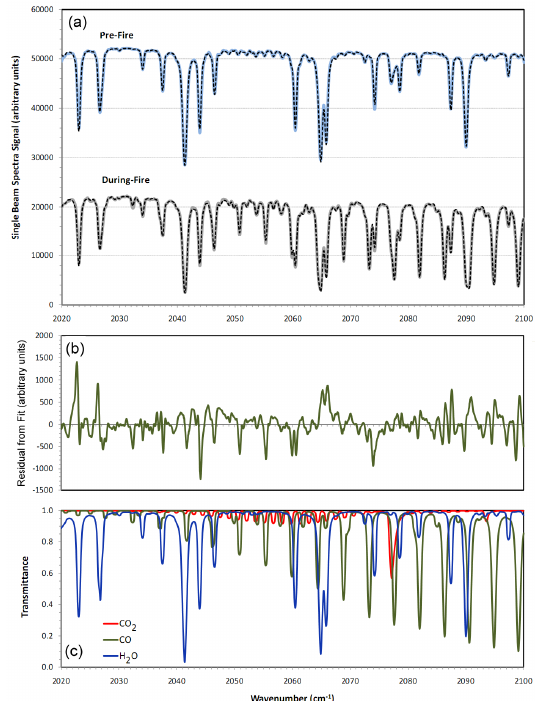
1403 1404 Fig. 5. Open path FTIR single beam spectra and best-fit forward modelled spectra for two example measurements recorded during Fire 1 (Table 1). Spectra were recorded by the deployed FTIR spectrometer operating in extended open path mode at 0.5cm − 1 wavenumber resolution, and the spectral window shown is the 2020–2100cm − 1 range used here for retrieval of CO 2 and CO abundances (Table 2). (a) Examples of single beam spectra mea- sured both prior to and subsequent to fire ignition, with the best-fit forward modelled spectra calculated using the retrieval procedure of Burton (1998) overlain in each case (dashed lines). The pre-fire and during-fire spectra correspond, respectively, to times 5 and 22min into the trace gas time series shown in Fig. 6. Pre- and during- fire spectra are shown offset for clarity. Note the greater number of strong absorption features in the during-fire spectra, caused by the increased within-plume trace gas abundances. (b) The resid- ual of the measured and best-fit forward modelled “during fire” spectra shown in (a) , indicating that no significant spectral features remain unfitted and confirming the strong agreement between the measured and forward-modelled spectra seen in (a) . Retrievals of CO 2 /CO column amounts from the pre-fire and during-fire spectra are equivalent to the ratio of path averaged mixing ratios (in ppmv) of 396/0.043 (pre-fire) and 758/25.1 (during-fire) respectively.